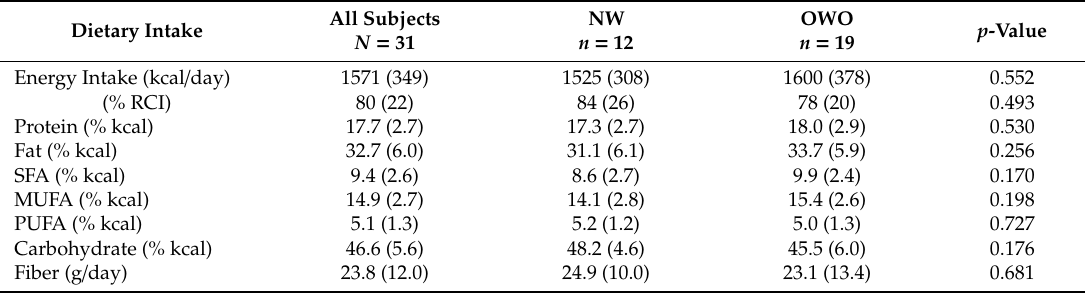
Table 2. Dietary intake analysis of participants.